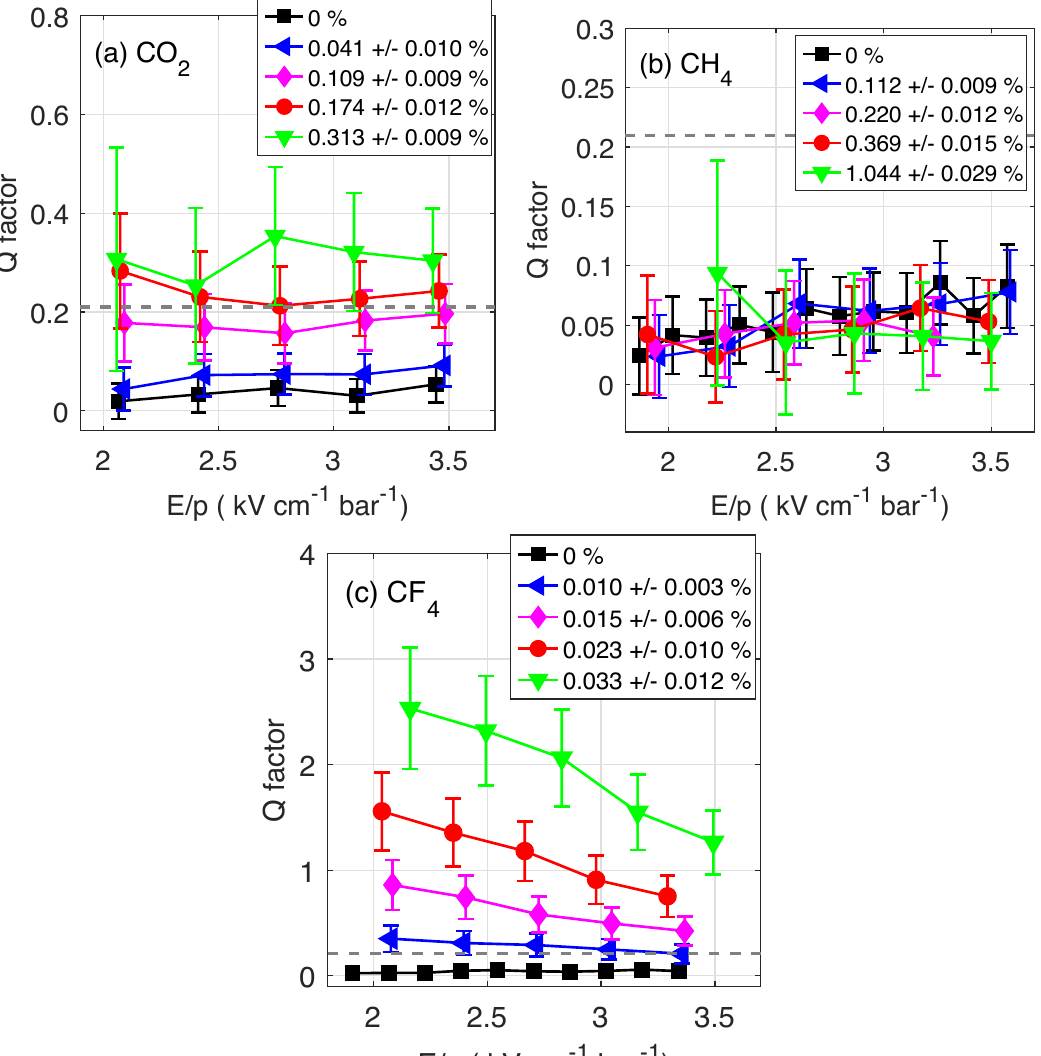
Figure 5 . Square of the relative standard deviation in the number of EL photons produced per primary electron ( Q ) as a function of E=p in the scintillation region (25 mm thick) for di(cid:11)erent concentrations of molecular additives: (a) CO 2 ; (b) CH 4 ; (c) CF 4 . Total pressures of 1.13, 1.25 and 1.24 bar were used, in average, for Xe-CO 2 , Xe-CH 4 and Xe-CF 4 mixtures, respectively. The horizontal dashed line indicates the Fano factor. The solid lines serve only to guide the eye.